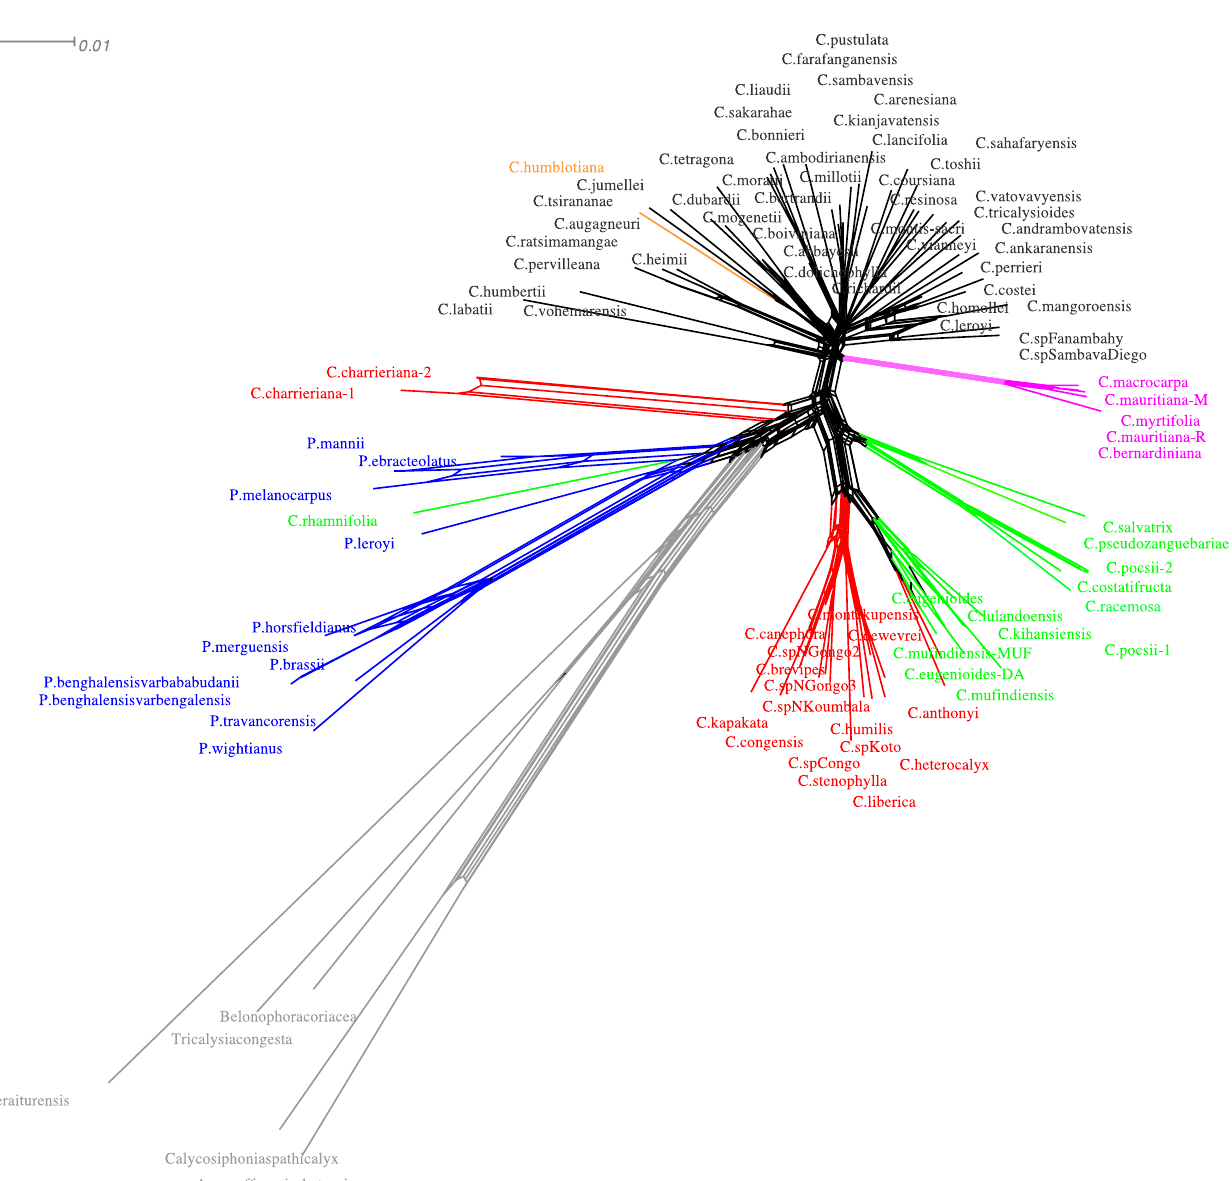
Fig 4. Nuclear phylogenetic network representation. The NeighborNet method of the Maximum likelihood nuclear phylogeny of coffee trees presented in Fig 3 was used to obtain the phylogenetic network.